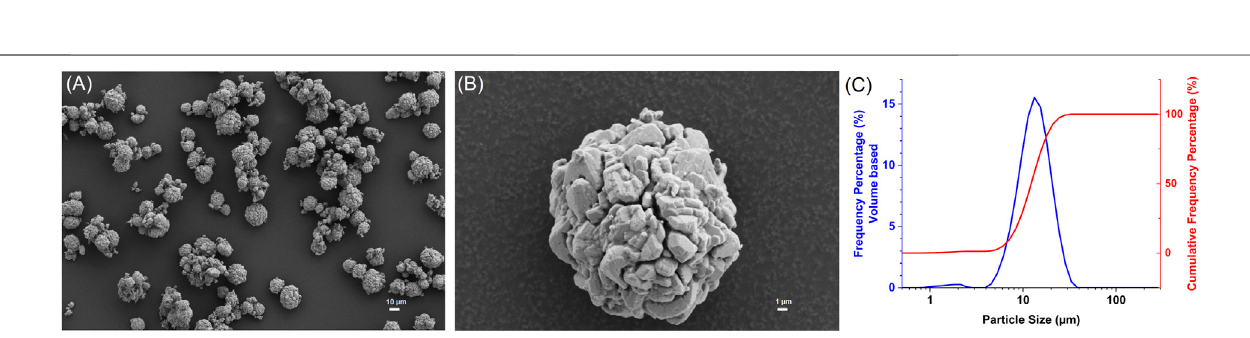
Frontiers in Energy Research |